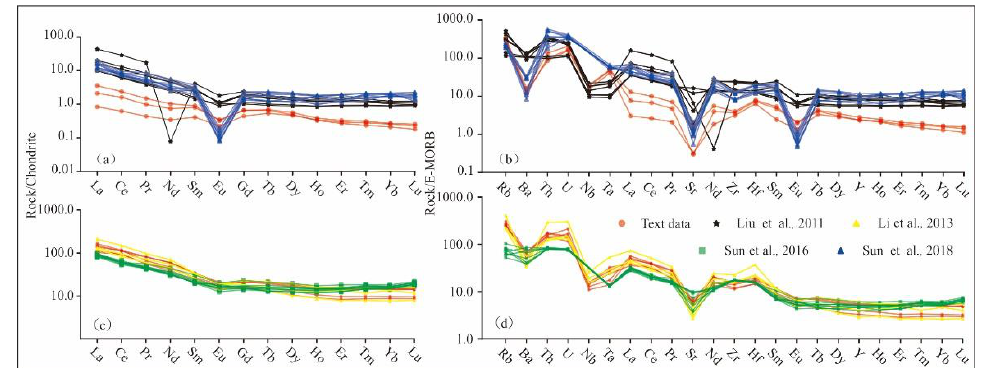
Figure 5. Chondrite-normalized REE and E-MORB-normalized trace-element spider patterns. ( a ) Chondrite-normalized REE patterns of volcanic rocks; ( b ) E-MORB-normalized trace-element spider patterns of volcanic rocks; ( c ) Chondrite-normalized REE patterns of intrusive rocks; ( d ) E-MORB-normalized trace-element spider patterns of intrusive rocks (normalizing factors are from [58]; Chondrite and E-MORB compositions are from [59]).